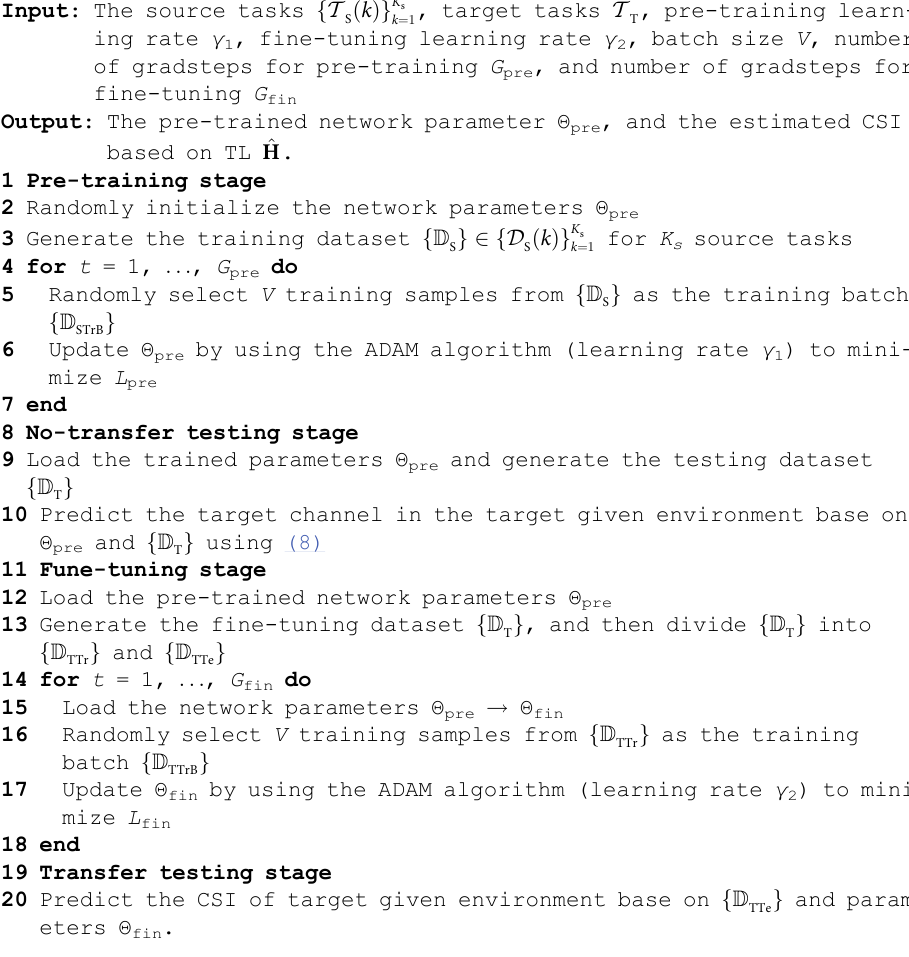
Algorithm 1 : Transfer learning for channel